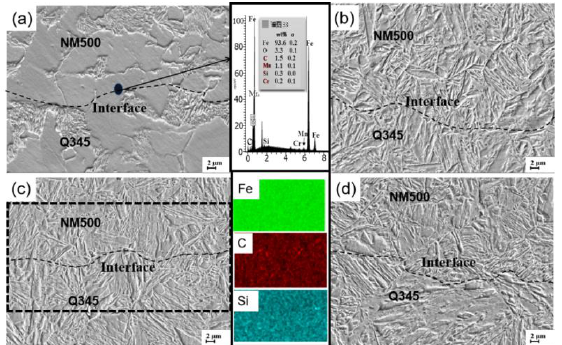
Figure 2. Microstructure and EDS of NM500/Q345 composite board in different states: ( a ) original; ( b ) 860 °C + 200 °C; ( c ) 900 °C + 200 °C; ( d ) 940 °C + 200 °C.